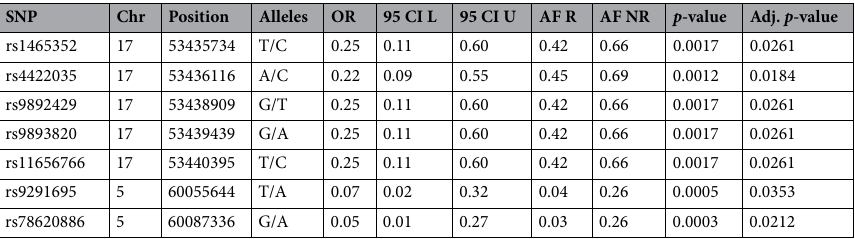
Table 3. SNPs significantly associated with anti-TNF response and located near genes differentially expressed in responders and non-responders according to our RNA-seq results. OR calculated for alternative allele and